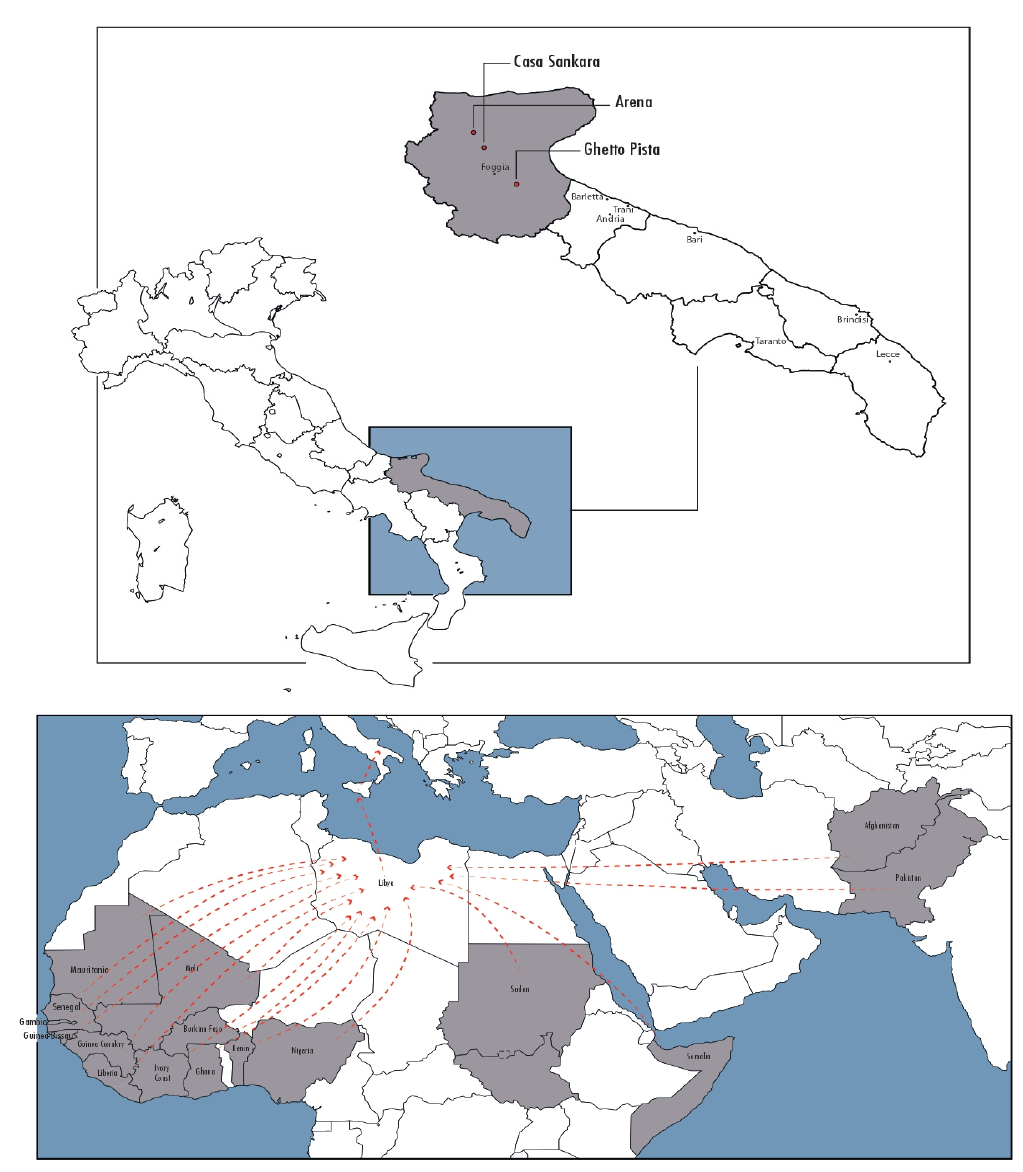
Figure 1. Localization of ghettos in Apulia region and countries of origins of